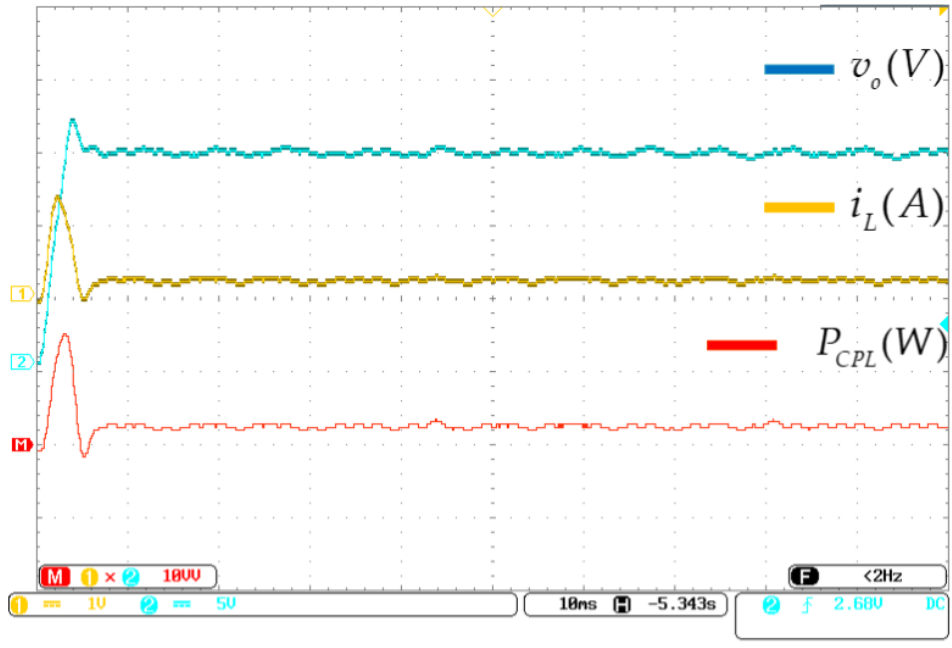
Figure 14. Experimental results: Time evolution of the output voltage, output current and power consumed by the CPL.